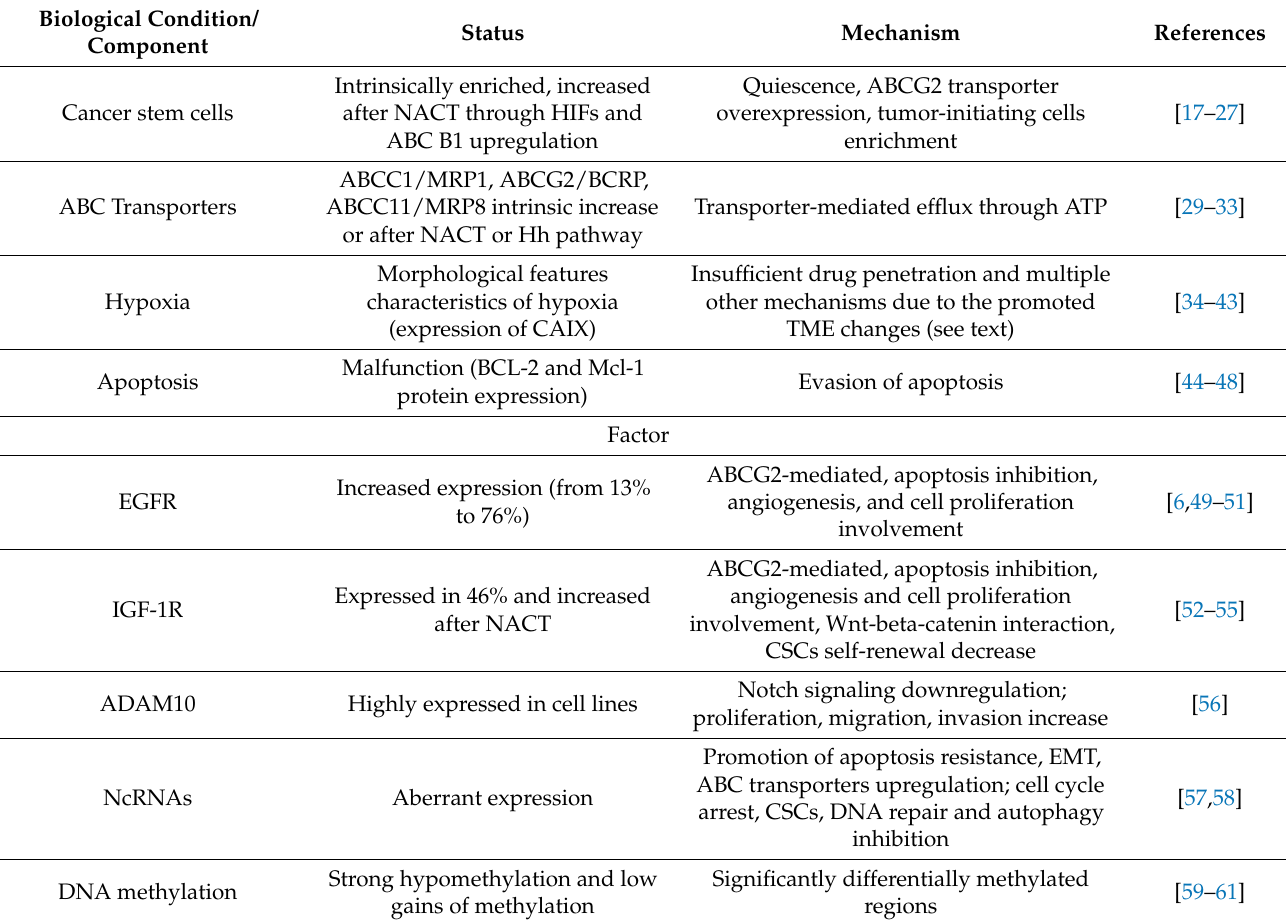
Table 1. Principal reasons likely responsible for chemoresistance in triple-negative breast cancer